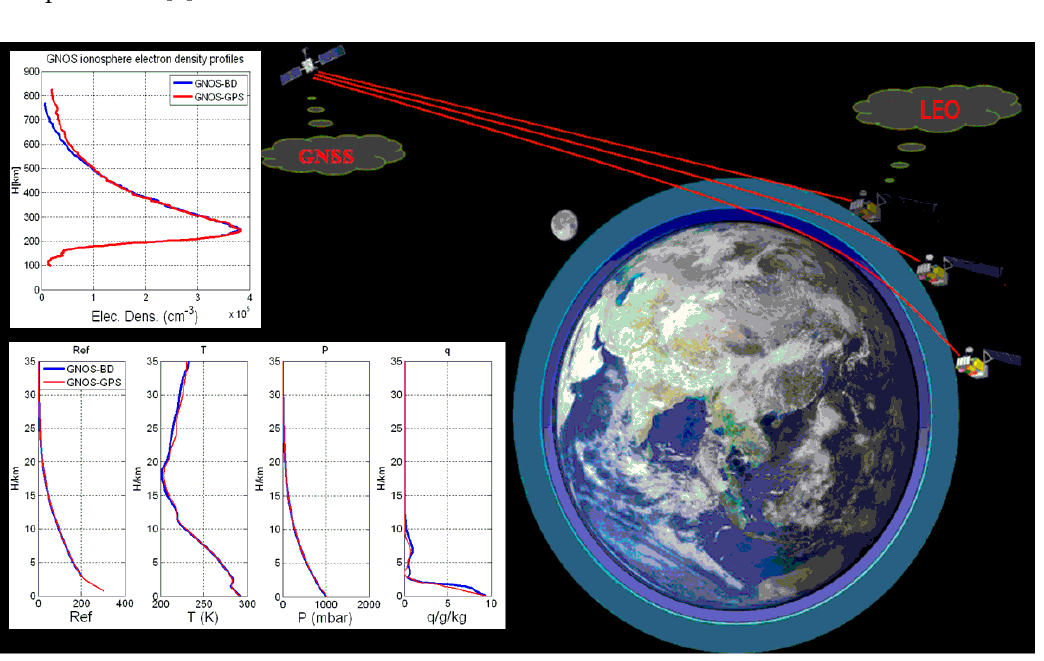
Figure 1. Schematic of radio occultation [4]. In the legend, the GNOS-BD (BeiDou) / GPS means global navigation satellite system (GNSS) occultation sounder (GNOS) received signals from Beidou / GPS satellite. The radio occultation (RO) phenomenon occurs when a GPS signal from the GNSS penetrates the Earth’s atmosphere and is then received by low-earth orbit (LEO) satellites behind the earth.